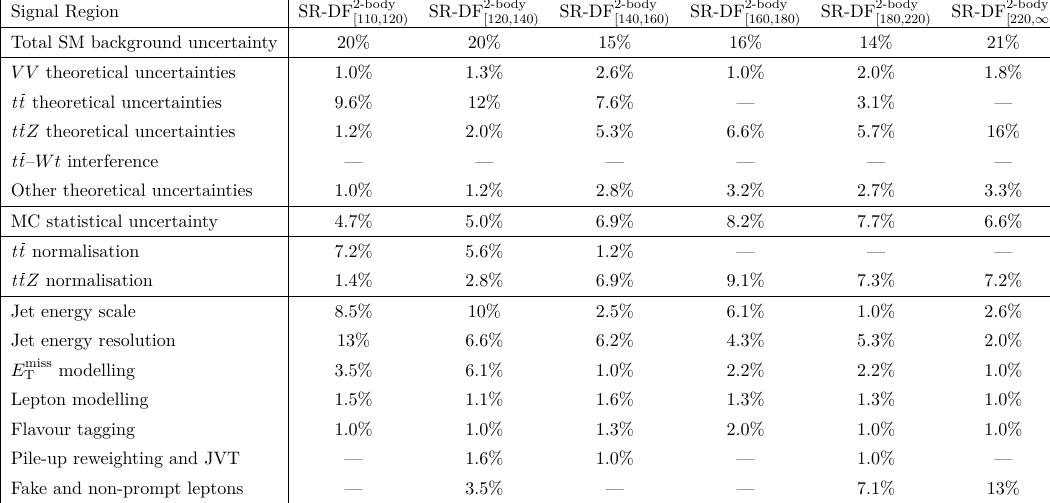
Table 13 . Two-body selection. Sources of systematic uncertainty in the SM background estimates, after the background fits, for the DF selection. The values are given as relative uncertainties in the total expected background event yields in the SRs. Entries marked ‘–’ indicate a contribution smaller than 1%. ‘MC statistical uncertainty’ refers to the statistical uncertainty from the simulated event samples. ‘Other theoretical uncertainties’ represent the theoretical uncertainty coming from V V V , tt t , tttt , tt W , tt WW , tt WZ , tt H , and tZ contributions. The individual components can be correlated and therefore do not necessarily add up in quadrature to the total systematic